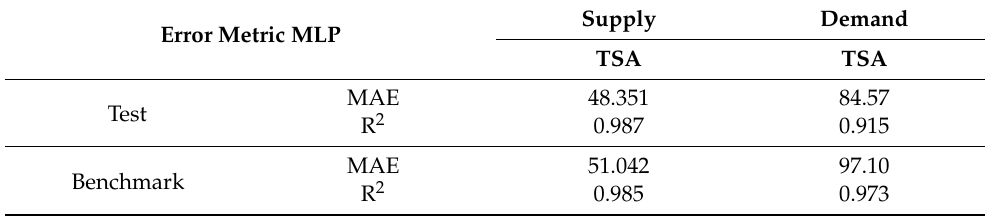
Table A3. Results of training an MLP on the same sample of the P2P-pricing dataset using the sklearn.neural_network.MLPRegressor class. The MLP consists of three hidden layers of 100, 200, and 50 neurons each and uses an adaptive learning rate starting with an initial value of 0.001. All other parameters are the default parameters of